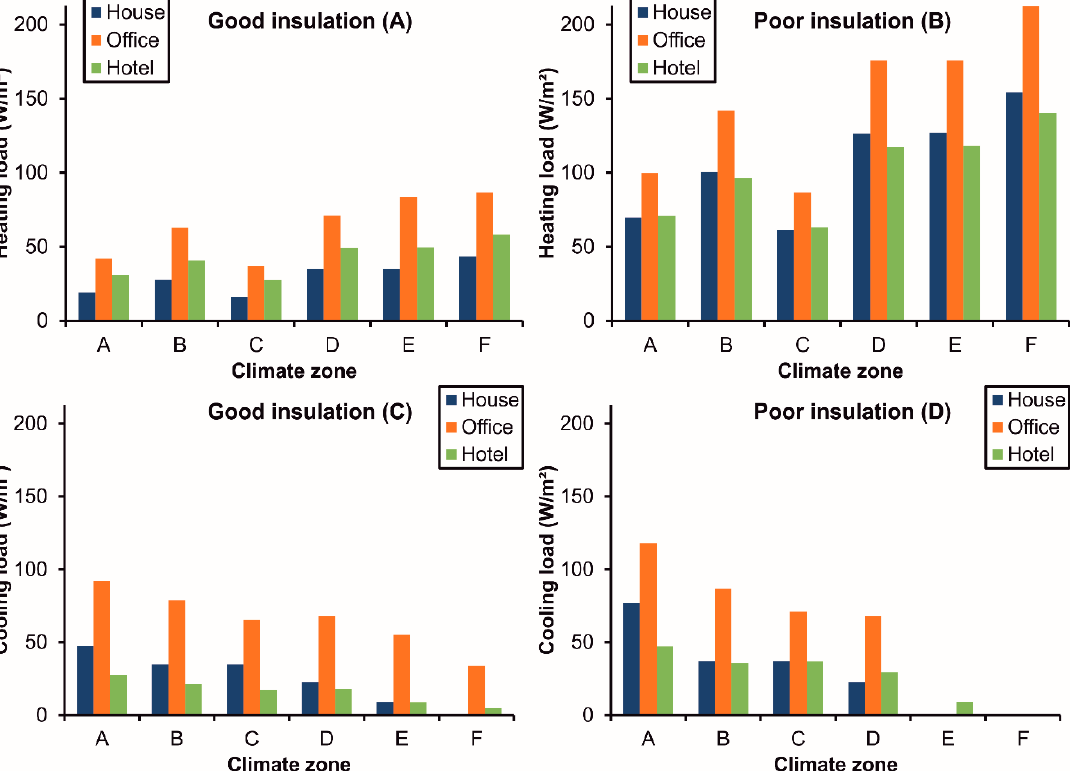
Figure 4. Heating peak loads with good insulation ( A ) and poor insulation ( B ) cooling peak loads with good insulation ( C ) and poor insulation ( D ), in different climate zones identified in Table 2.